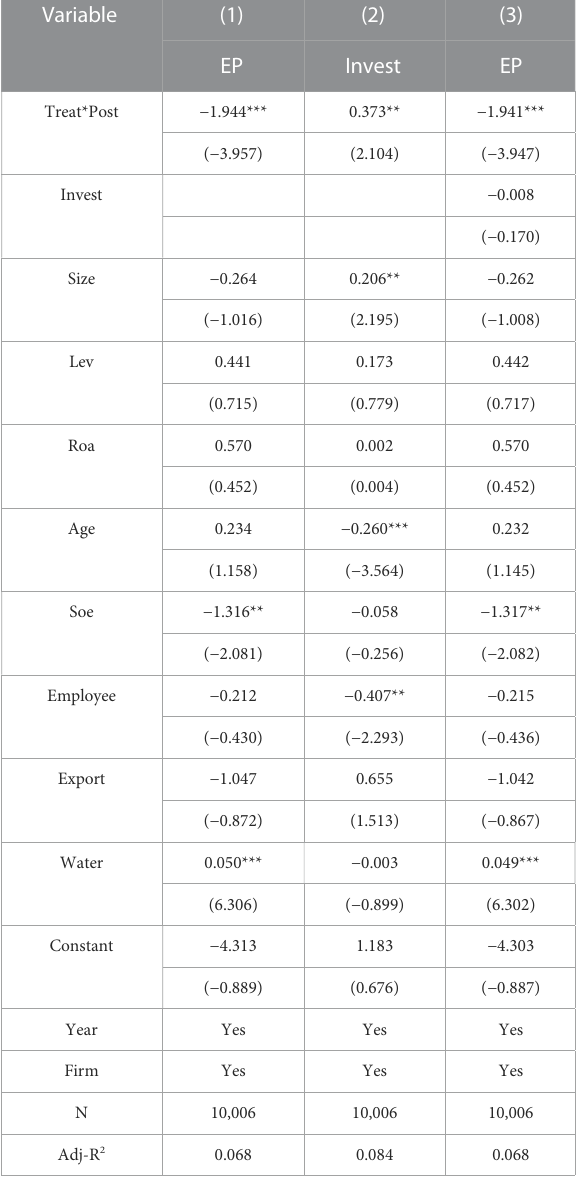
TABLE 8 NSMF program, investment, and corporate environmental